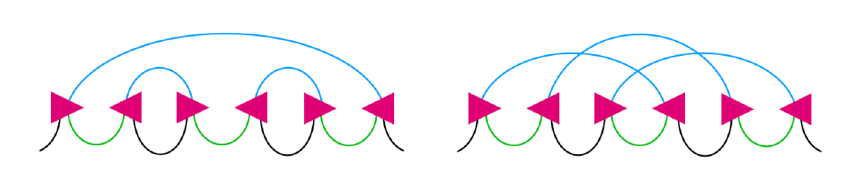
Figure 10 . (Left) An example of the planar diagram in the calculating ρ 3 , featuring a non-crossing permutation for the contraction. (Right) An example of a non-planar diagram. The contribution is always suppressed by powers of χ